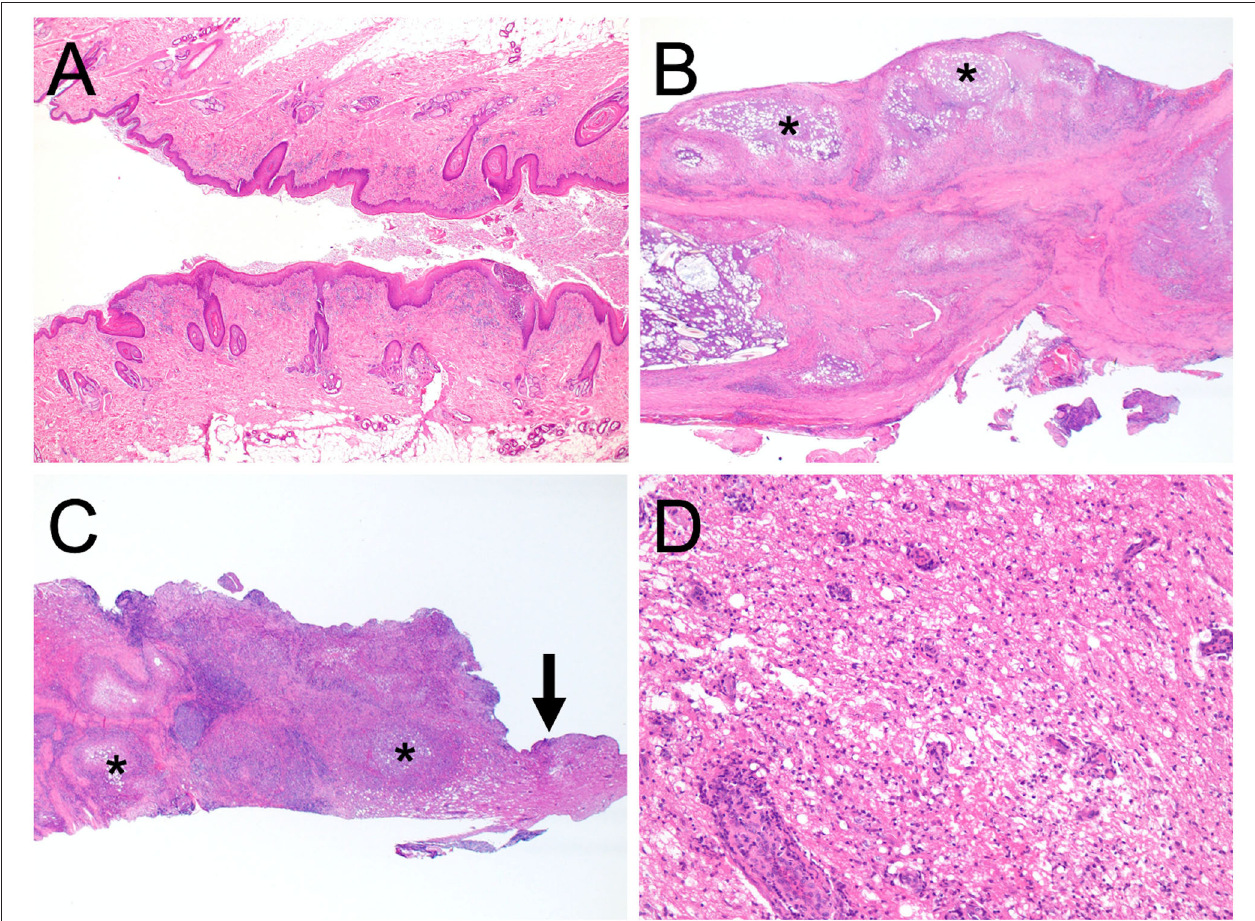
FIGURE 4 | Histopathological microphotographs of the excised dermoid sinus. The resected tissues contained the orifice of the skin (A) , granulomas within the subcutaneous tissues (B) , and the intradural part of the dermoid sinus (C) ( × 2 magnification). Squamous epithelial cells formed follicle-like cystic structures containing sebaceous glands and sweat glands. There were connective tissues around squamous epithelial cells with infiltration of lymphocytes, plasma cells, and mast cells. Keratinous materials, clumps of bacteria, and neutrophils were present in the dermoid sinus tract. Neutrophils, lymphocytes, and macrophages invaded the intradural tissues and formed granulomas around the keratinization with hyperplasia of collagen fibers. Granulomatous inflammation is indicated (asterisk). (D) Corresponds with the magnified area of the intradural tissue (arrow) in (C) , × 200 magnification. Perivascular cuffing, edema, degeneration, and diffuse hypercellularity were observed in the excised tissue containing the spinal white matter. All sections were stained with haematoxylin and